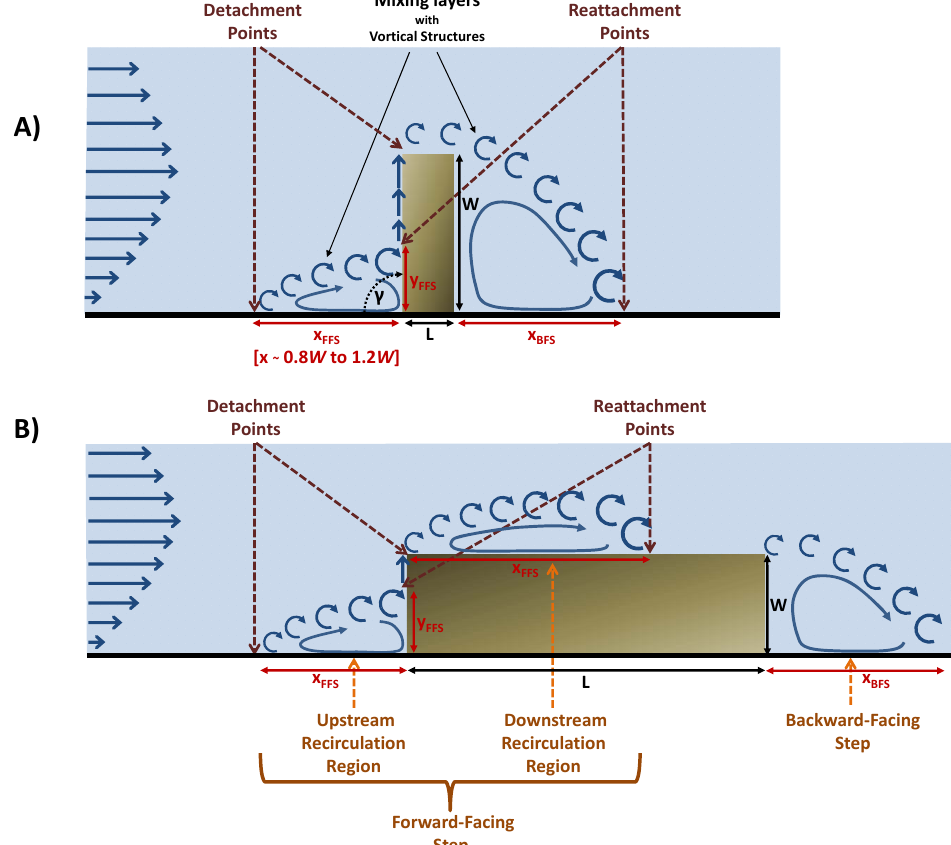
Fig. 5. Schematics of the flow field for a forward-facing step with two different in-stream flow obstruction orientations: (A) W >L and (B) W <L